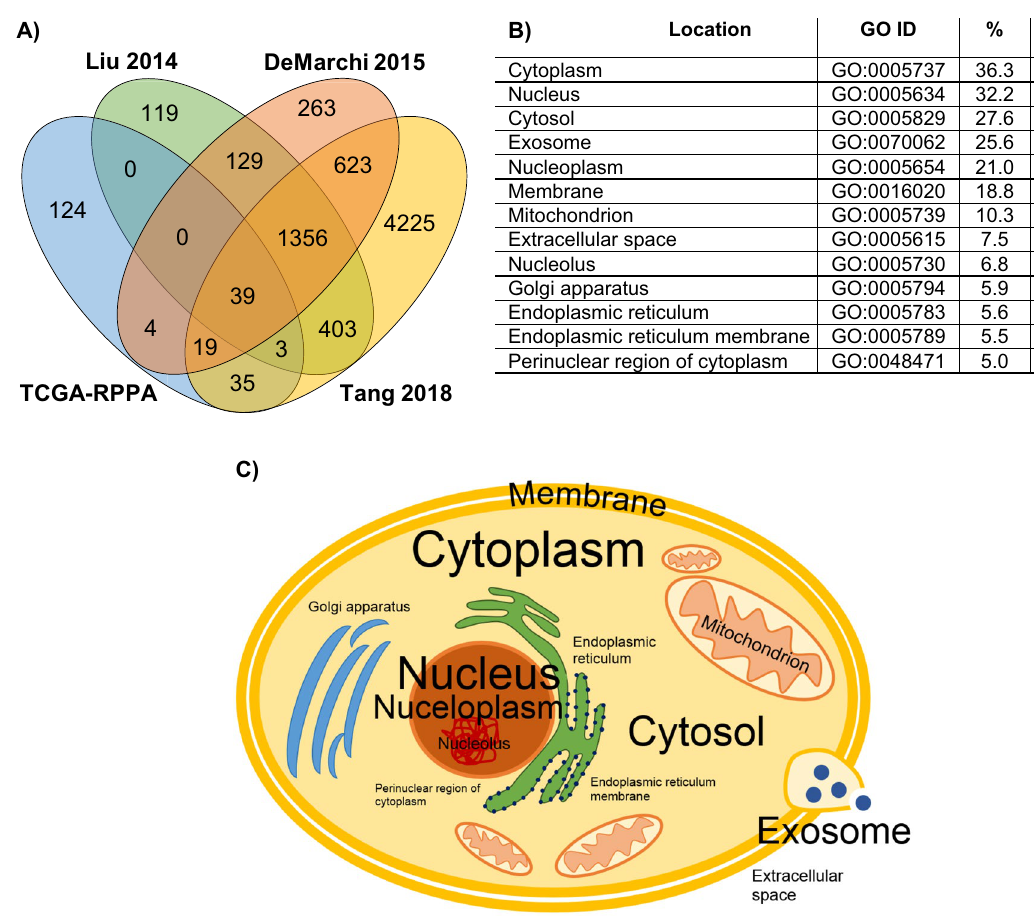
Figure 3. Proteins measured in multiple studies and their cellular localizations. ( A ) Number of proteins represented in one, two, three, or four datasets, ( B ) proportion of proteins present in various cellular components, and ( C ) graphical representation of cellular origin of the analyzed proteins, where font size is relative to the proportion of proteins from that